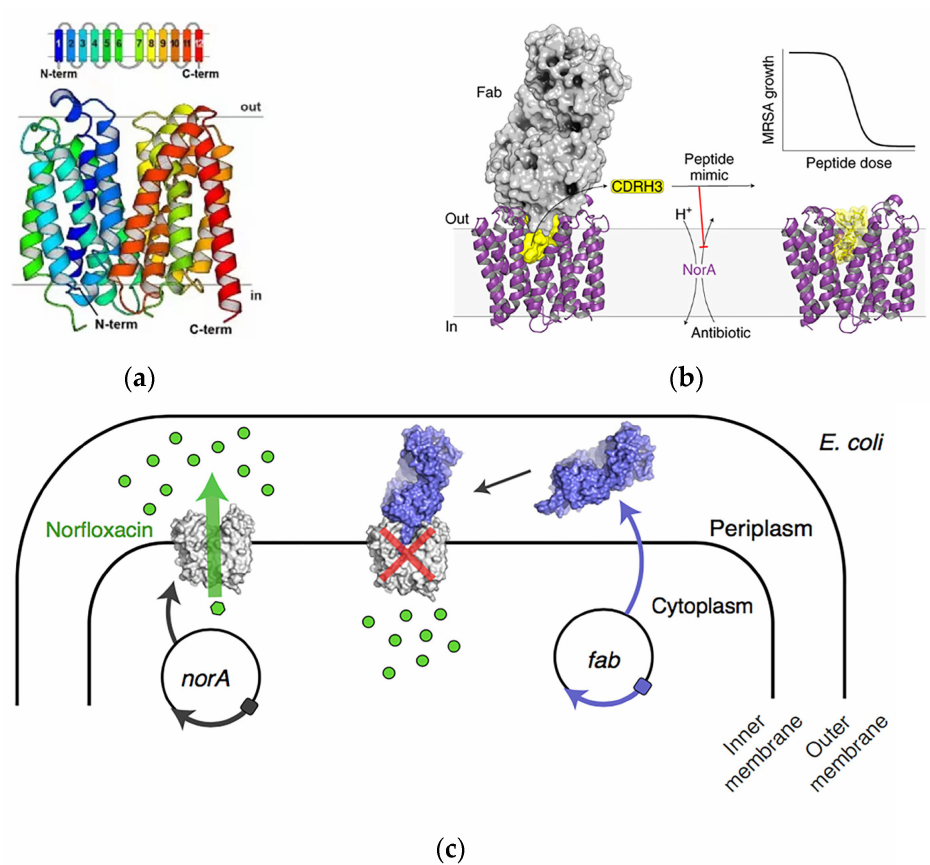
Figure 6. Inhibitors of the NorA efflux pump. ( a ) NorA topology and structure. The TM helices of NorA are colored in rainbow. TM1–TM6 and TM7–TM12 define the N and C domains of the transporter, respectively. ( b ) Schematic of the structure of the inhibitor bound to the substrate pocket. ( c ) Schematic of the mechanism of action of the Fab ring reversal for the restoration of antibiotic activity in drug-resistant bacteria. Adapted with permission from [72], Copyright 2022 Springer